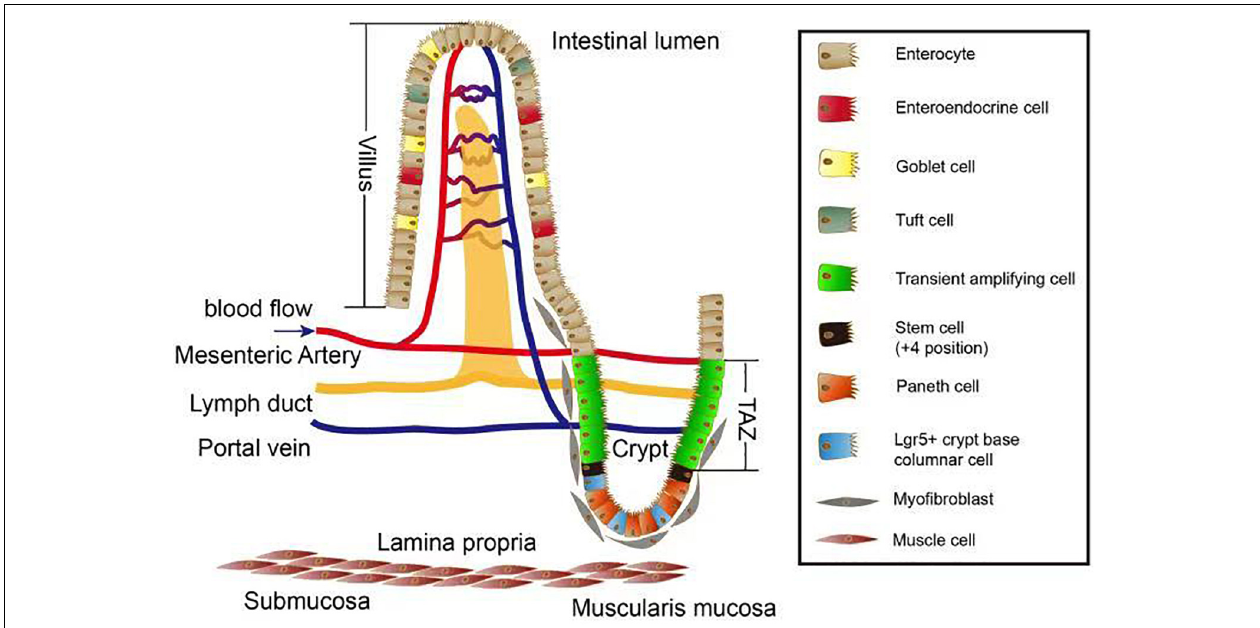
FIGURE 1 | Overview of the intestinal villus/crypt system. Several cell types exist along the crypt–villus axis. Paneth cells, Lgr5+ crypt base columnar cells, and the (+4 position) stem cells together form a crypt stem cell niche which is surrounded by myofibroblasts. After differentiation, the stem cells give rise to different cell types located in villus zone. Stem cells proliferate and become part of the transient amplifying zone (TAZ). These proliferating cells move upward to the top of villus and differentiate into cells important for nutrient absorption such as enterocytes, tuft cells, goblet cells, and enteroendocrine. The lamina propria is where mesenteric artery propria, lymph duct, and portal vein intersect and maintain the homeostasis in terms of blood circulation as well as lymphatic